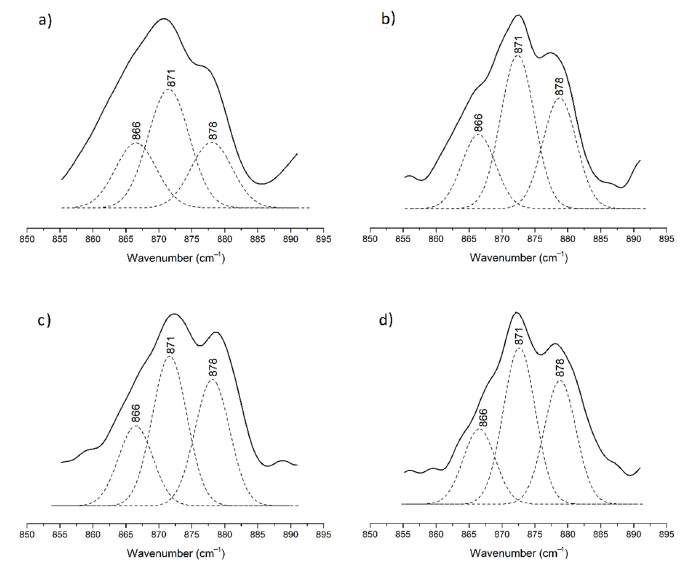
Figure 1. ATR-FTIR peaks profile in the carbonate absorption band v 2 CO 32 − : ( a ) sound dentine, ( b ) carious dentine, ( c ) pH cycling (pHc) for 14 days, and ( d ) pHc for 28 days. The three peaks assignment correspond to unstable-labile carbonate ( ∼ 866 cm − 1 ), type B carbonate ( ∼ 871 cm − 1 ), and type A carbonate ( ∼ 878 cm − 1 ).